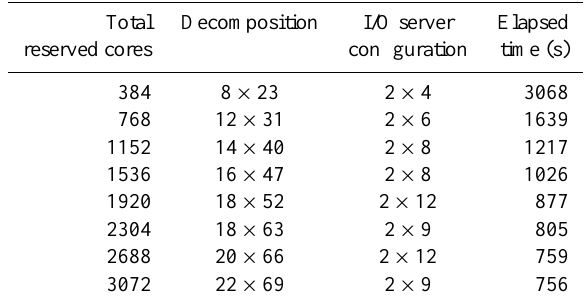
Table 3. The best elapsed times for N512L70 on Ngamai using 2 threads on fully committed